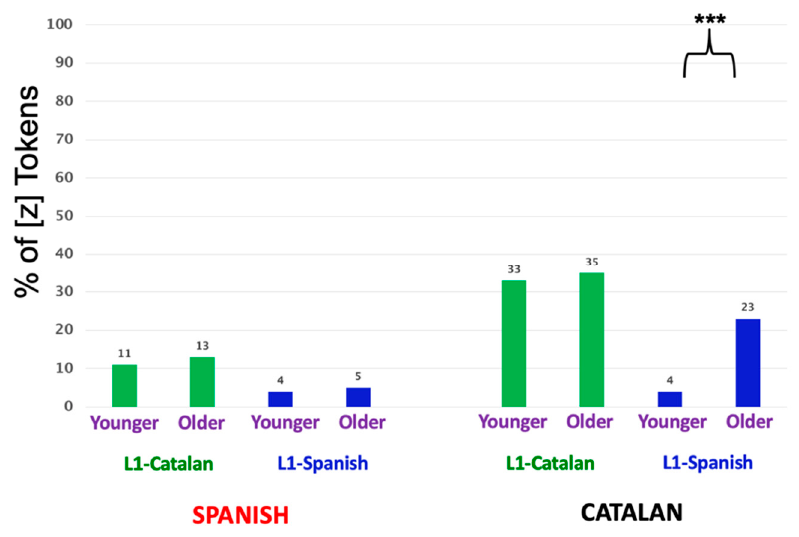
Figure 11. Effect of age as mediated by language profile and language on Valencian fricative production.